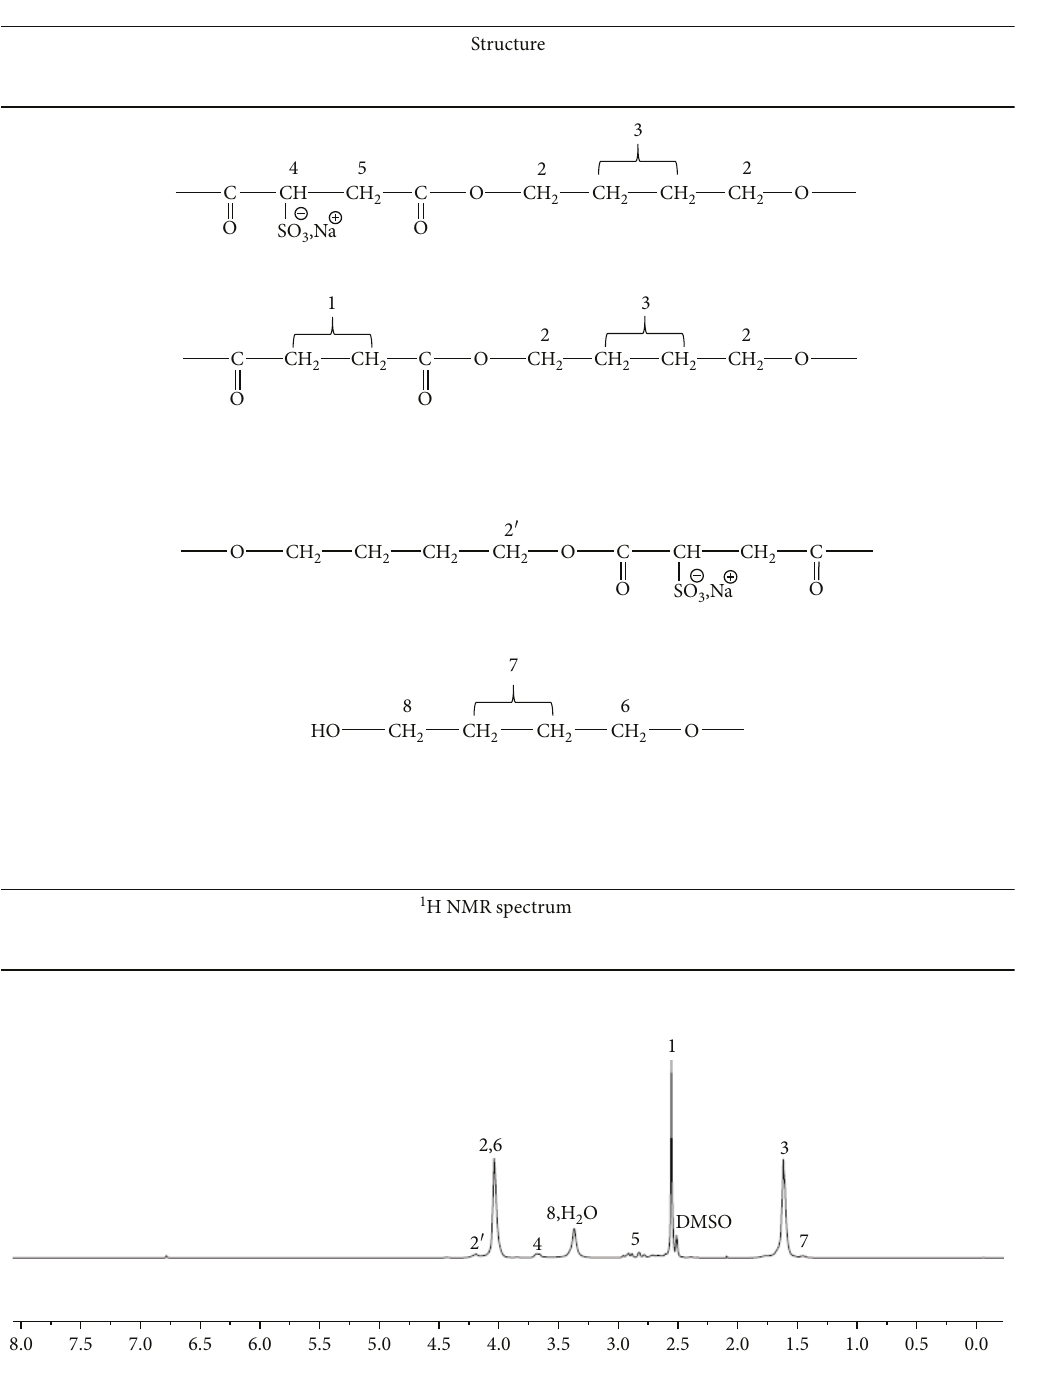
Figure 1: 1 H NMR characterization of PBSu